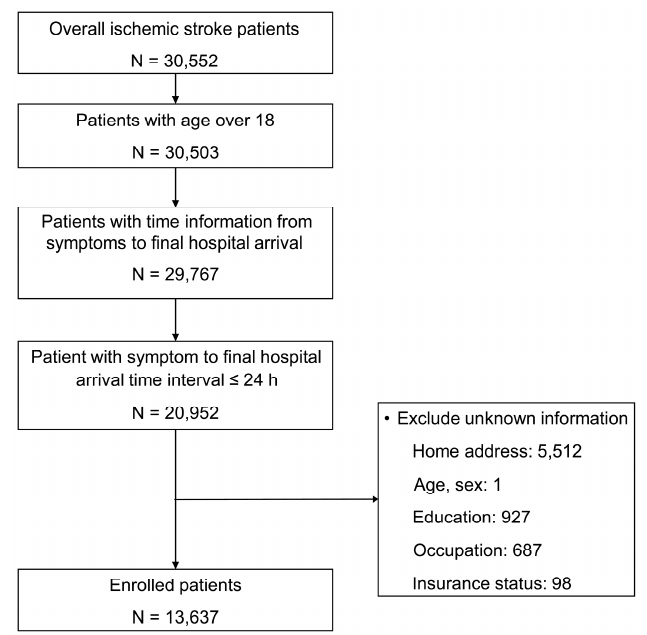
Figure 1. Flow chart showing patient recruitment according to the inclusion and exclusion criteria.